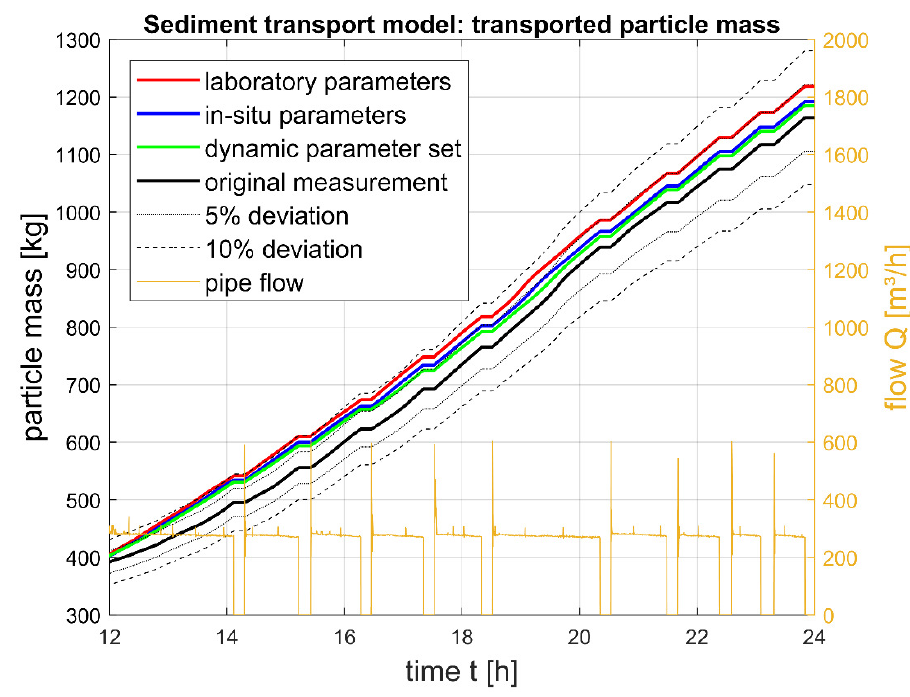
Figure 5. Results of the sediment transport simulation. Cumulative particle mass transport measured and simulated with laboratory, in situ, and dynamic parameters. Table 1. Simulated pump control modes with significant